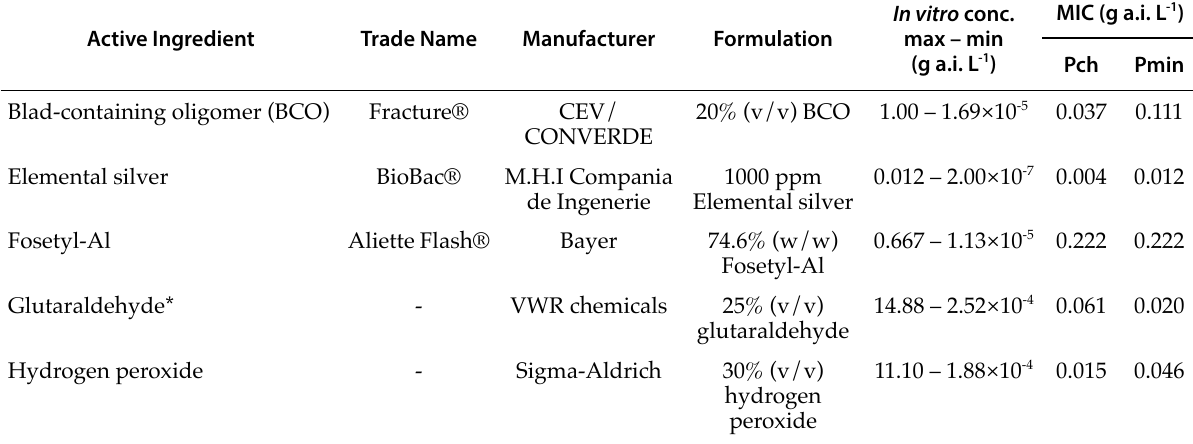
Table 1. Chemicals tested against Phaeomoniella chlamydospora (Pch) and Phaeoacremonium minimum (Pmin), the range of concentrations of active ingredients (a.i.) tested in vitro , and the minimum inhibitory concentrations (MICs) of each chemi-